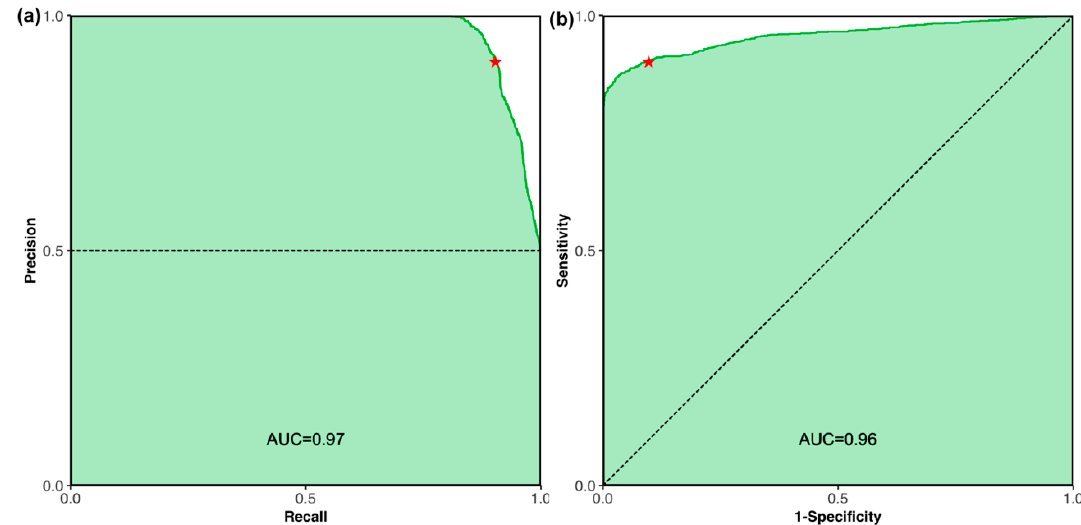
Figure 7. Principal component analysis (PCA) plot of RGO–metalloporphyrin-sensing response was obtained.